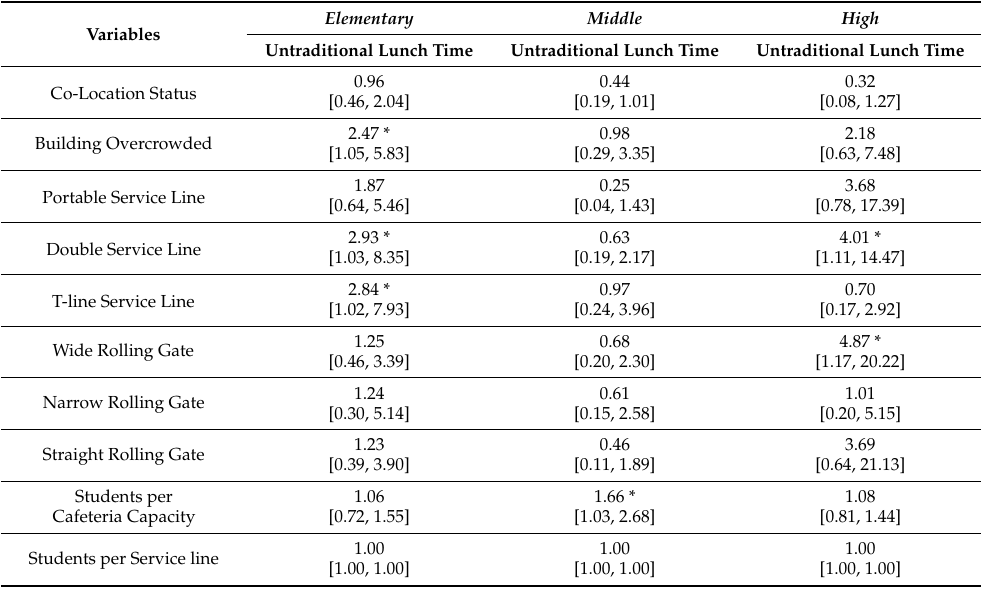
Table 3. Logistic Regression Results for Untraditional Lunch Times by School Level in New York City Public